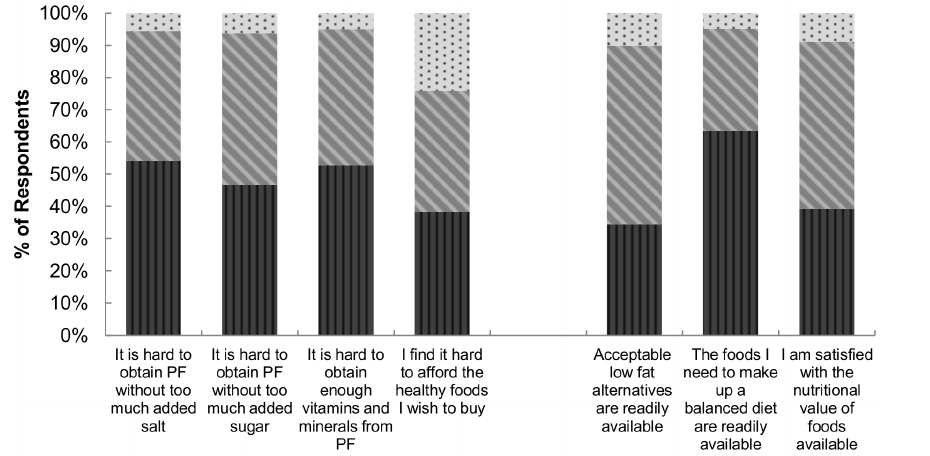
Figure 3. Perceptions of CCM respondents* (N=6,665) regarding select statements about the availability of ‘‘healthy’’ foods sold in Canada { . *Respondents were weighted to be representative of the Canadian population by age, sex, and province according to the 2006 census data. { 1=completely disagree; and 7=completely agree: 1–2; 3–5; and 6–7. CCM: Canadian Consumer Monitor. PF: Processed Foods. Survey question: Please indicate the degree to which you agree or disagree with each of the following statements on the scales